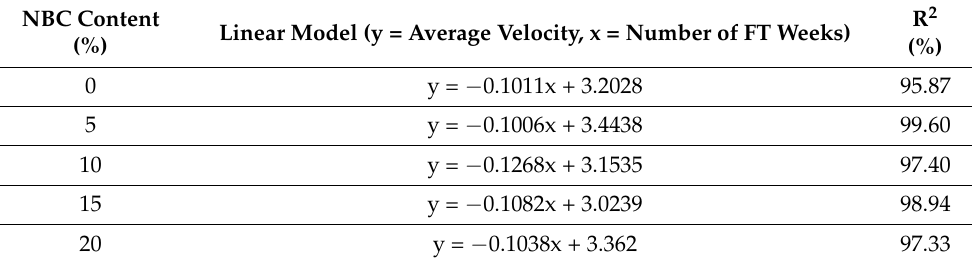
Table 4. Developed linear models between average velocity and number of FT weeks.